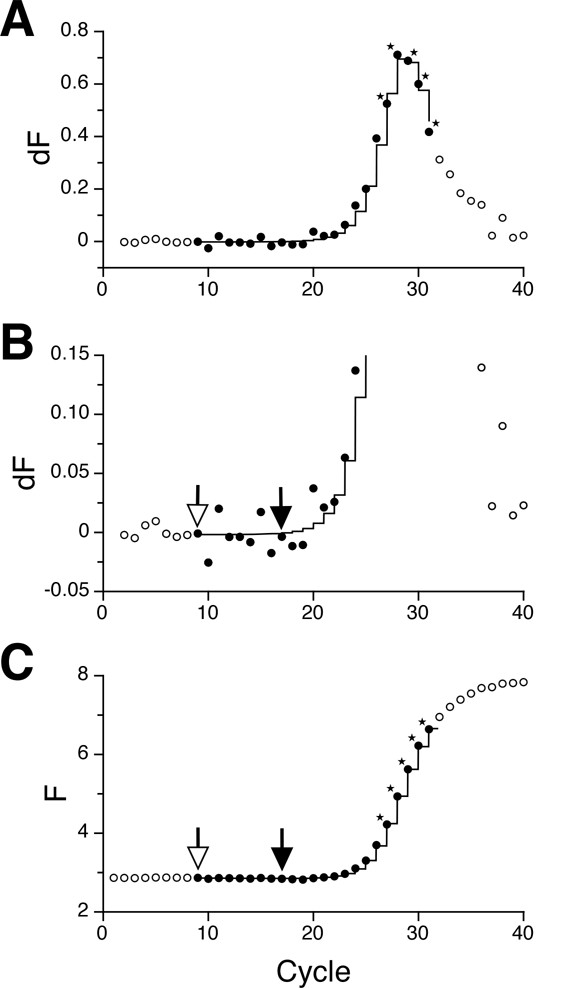
Selection of points. (A) Fluorescence difference (dF) as a function of cycle number with data from a hydrolysis probe assay run on a LightCycler™. Filled circles were used for fitting with function EAvPeak; fitting results are displayed as line graph. Circles marked by an asterisk indicate the 5 point peak. (B) As part A, but at higher magnification on the y axis. Points for definition of background fluorescence are selected as follows: each position i, going down cycle by cycle from the 5 point peak, is checked until the dF values of at least 3 points in the interval i-8 to i-1 surpass the reference level, which is the average dF of points i, i+1, and i+2. The upper limit of the background definition interval, denoted by a filled arrow, corresponds to i; the lower limit, denoted by an open arrow, is at i-8. Finally, slope and offset of the background line is determined by linear regression on the raw fluorescence data at i-8 to i. (C) Corresponding raw fluorescence data. Fitting results from function EAv are displayed as line graph. Open circles represent points that were excluded from fitting. Asterisks and arrows as above.